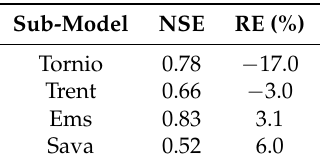
Figure 1. Geographical locations of the four sub-models selected for the hydrological simulation tests. The sub-models cover parts of ( A ) Tornio, ( B ) Ems, ( C ) Trent and ( D ) Sava river catchments. White dots denote the locations of the discharge gauging stations for which the reference period statistics are shown in Table 2. Table 2. Statistics for daily time-series of simulated river discharge calculated against the observed discharge at the mouth of each hydrological sub-model (cf. Figure 1). The first column shows the catchment name, the second column Nash-Sutcliffe efficiency coefficient and the third column the relative volume